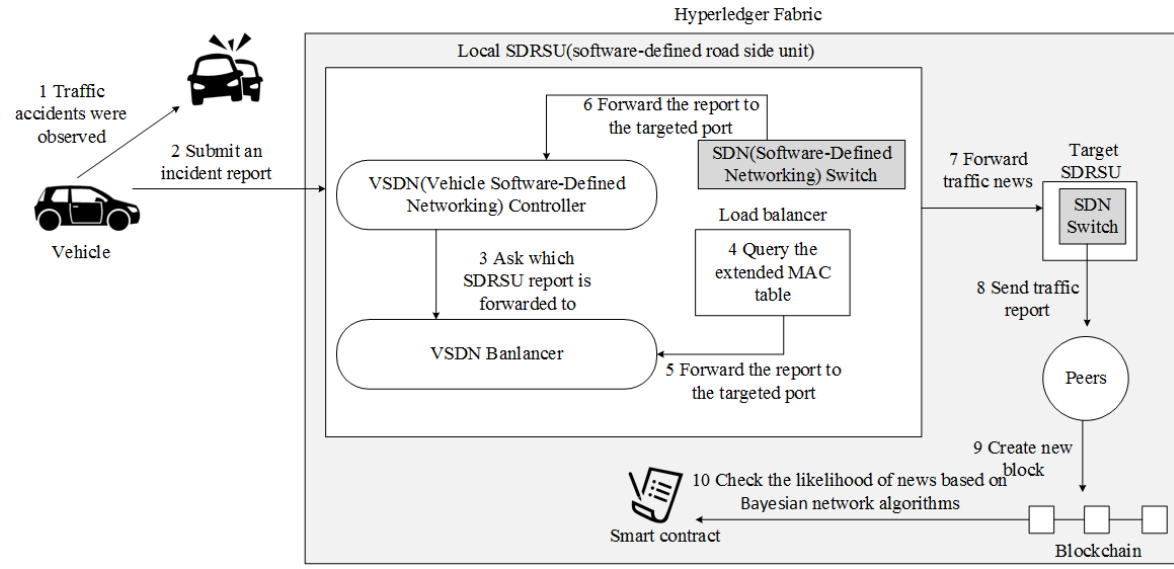
Figure 38. Reconstruction diagram of reference [70].